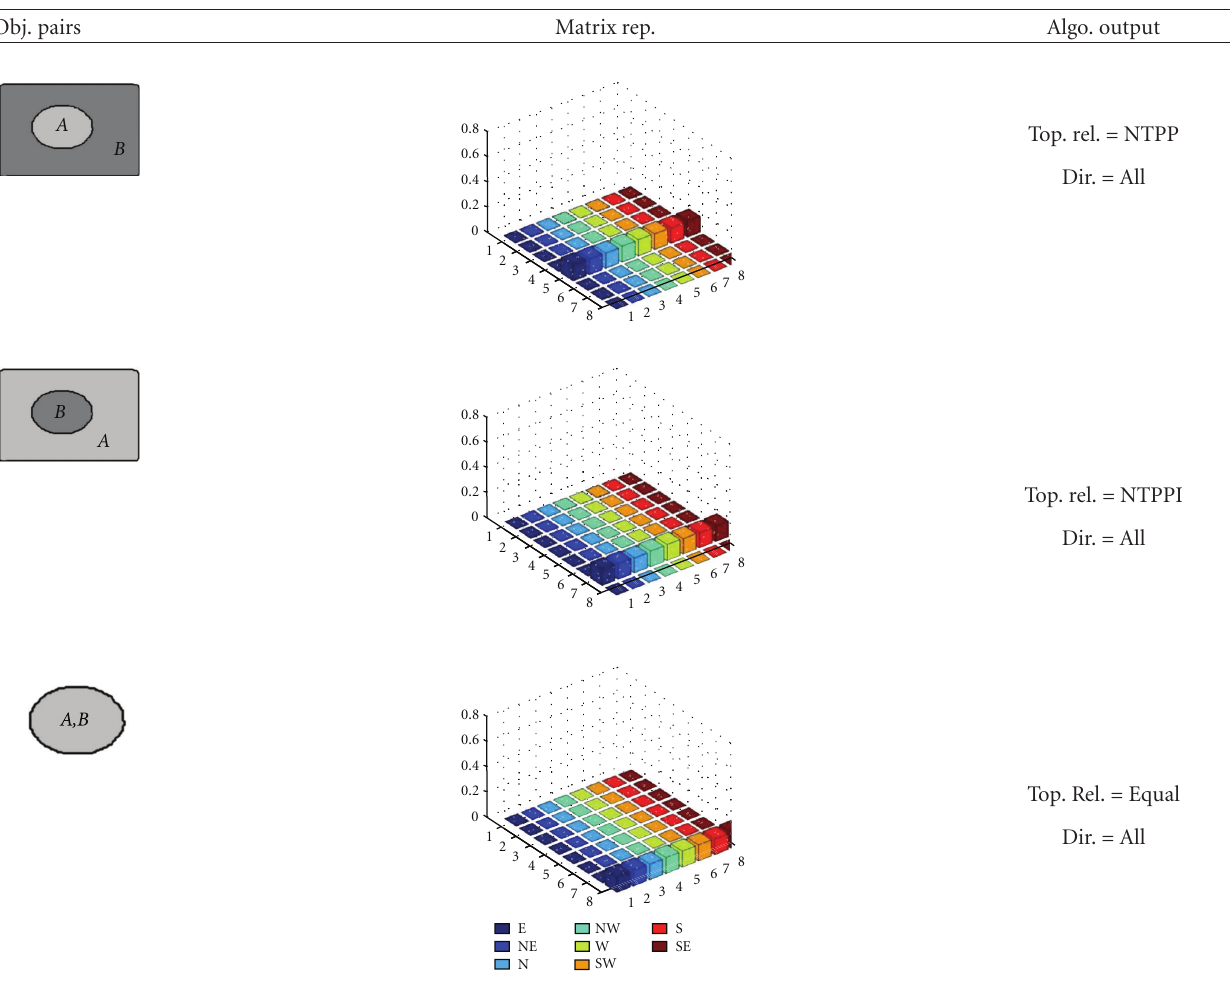
Top. rel. = NTPP Dir. = All